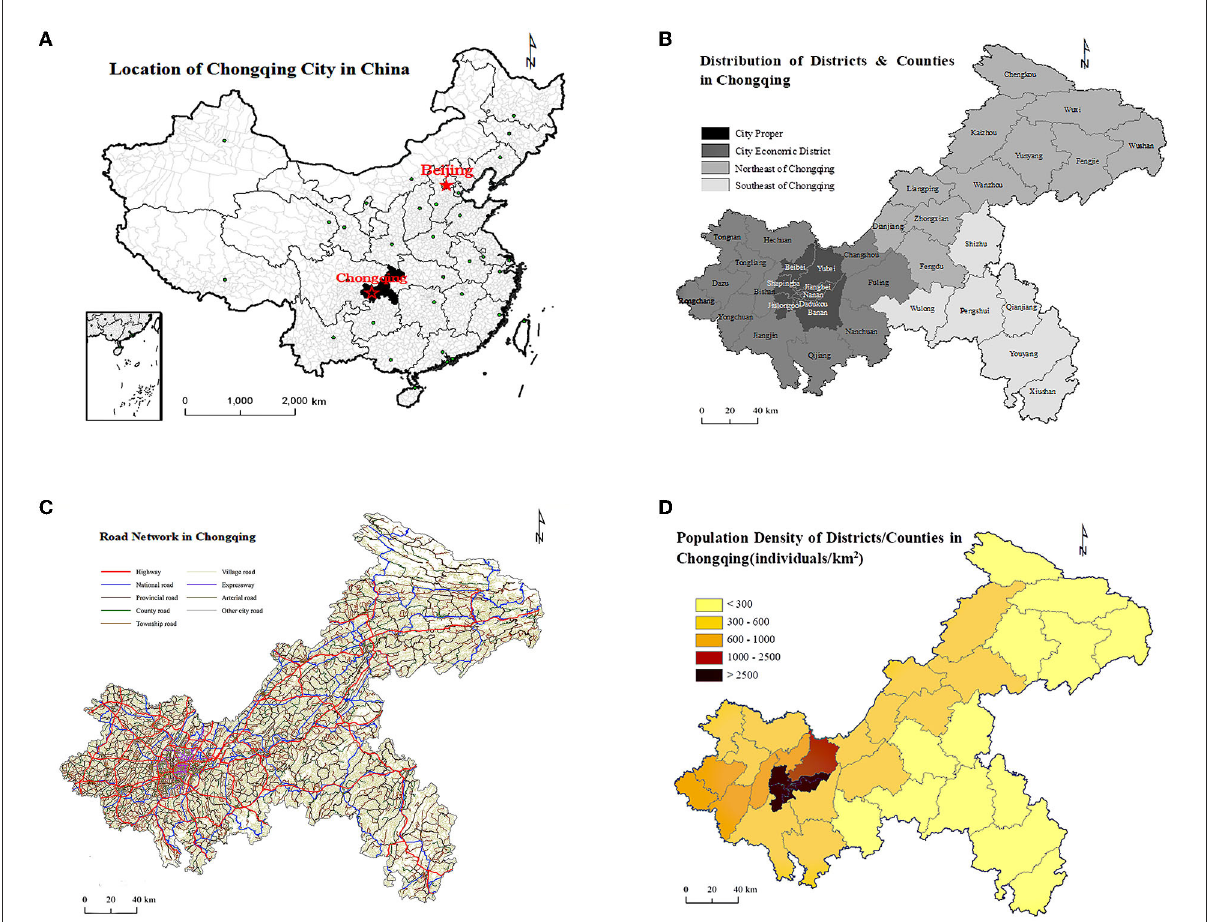
FIGURE1 (A) Location of Chongqing in China. (B) Distribution of districts and countries in four economic zones. (C) Road network. (D) Population density of Chongqing,